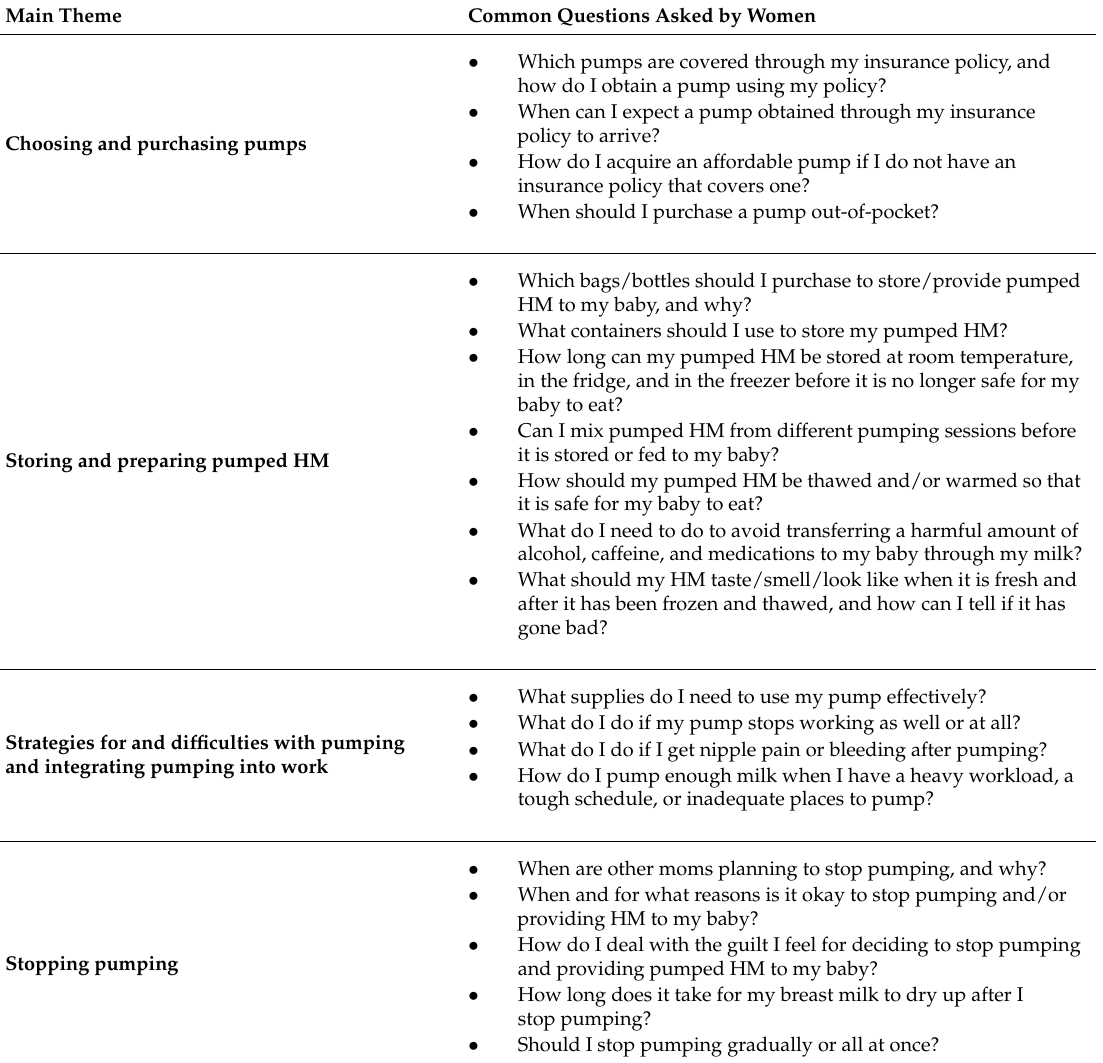
Table 3. Themes and common